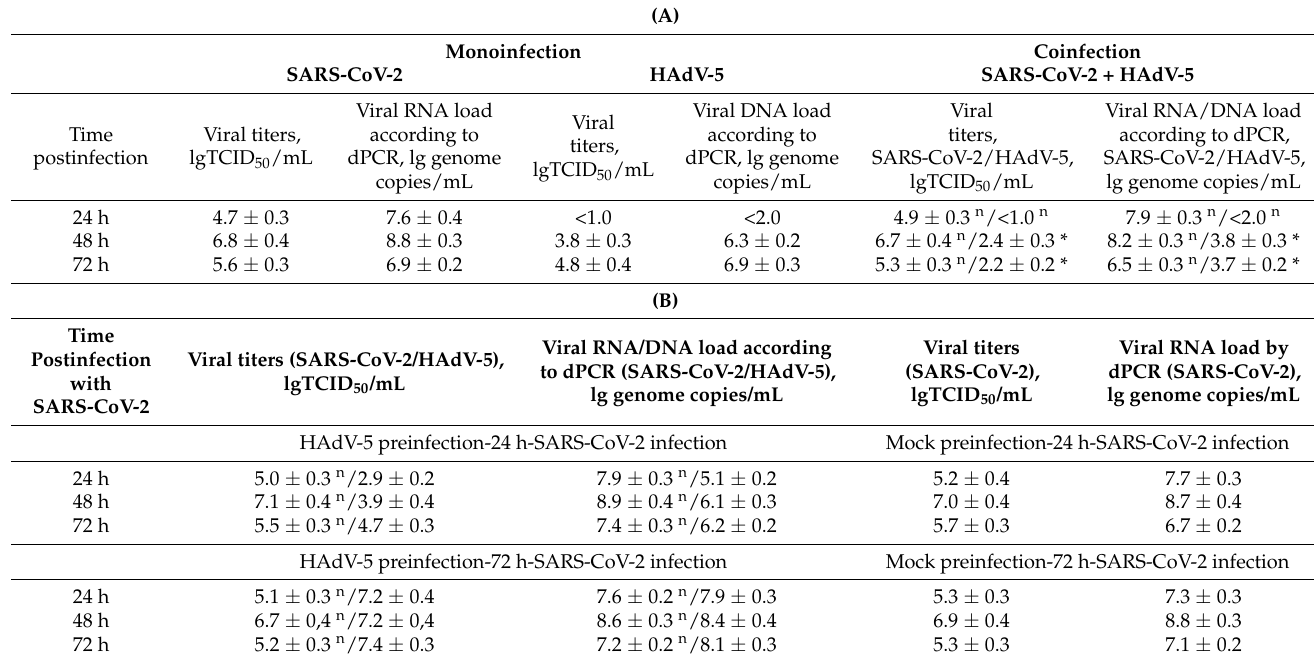
Table 1. Modelling of HAdV-5 and SARS-CoV-2 coinfection in vitro during simultaneous ( A ) and consecutive ( B ) infection of Vero E6 cells (MOI 0.1 TCID 50 ). (A) Monoinfection Coinfection SARS-CoV-2 HAdV-5 SARS-CoV-2 + HAdV-5 Viral DNA load Viral Viral RNA/DNA load according to titers, according to dPCR, dPCR, lg genome SARS-CoV-2/HAdV-5, SARS-CoV-2/HAdV-5, lgTCID 50 /mL copies/mL lgTCID 50 /mL lg genome